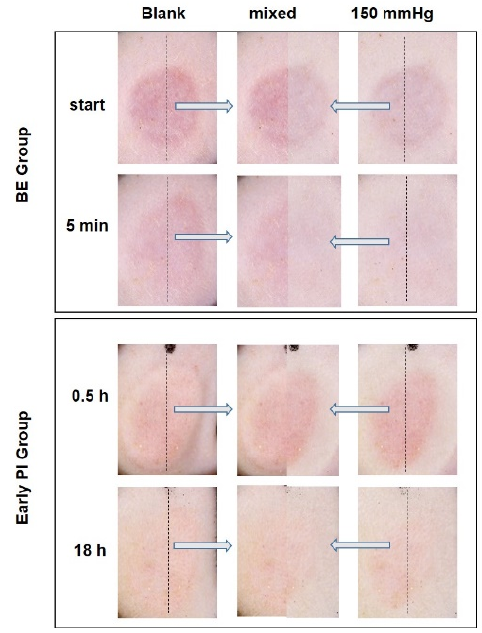
Figure 5. Observation of false positives and false negatives of erythema when the transparent disc was applied. Photographs taken by the Dermo-camera show the loaded area of the BE group at the start and 5 min after decompression before and after the use of transparent disc method. Blank ( left ) and 150 mmHg ( right ); merged pictures ( middle ). Pictures taken using the Dermo-camera showed the loaded area of the early PI group 0.5 and 18 h after decompression before and after the application of the transparent disc method. Blank ( left ) and 150 mmHg ( right ); merged pictures ( middle ).